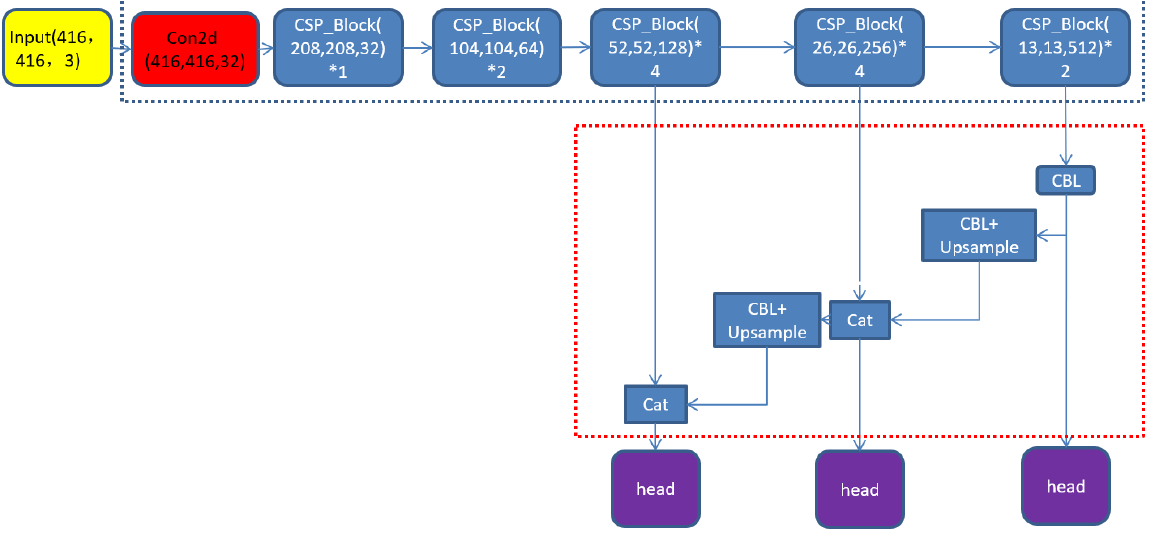
Figure 4. Network of neck modification.